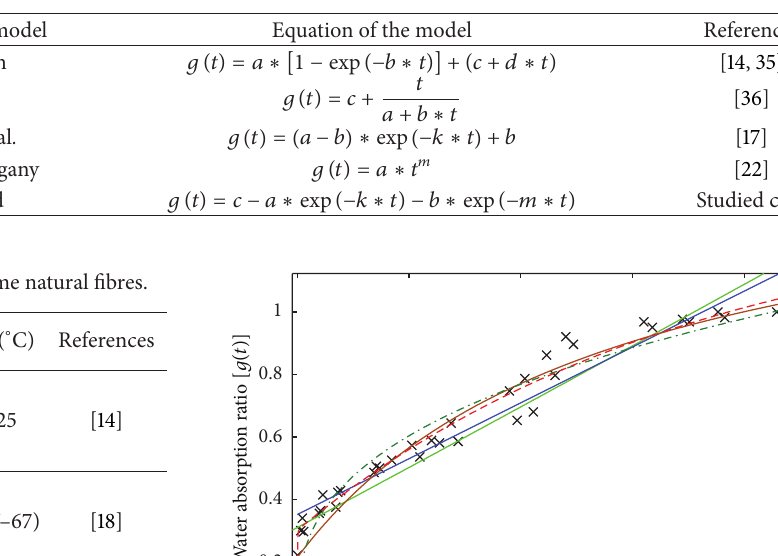
Table 1: Synthesis of the different models used for the study of water absorption of vegetables fibres.